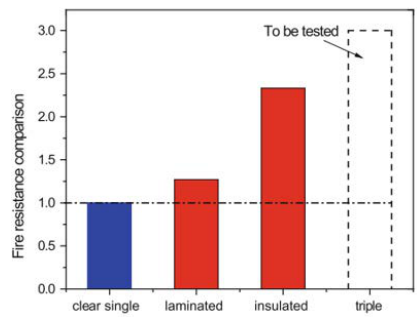
Fig. 12 Breakage time comparison of different kinds of layered glass products (Wang 2020).